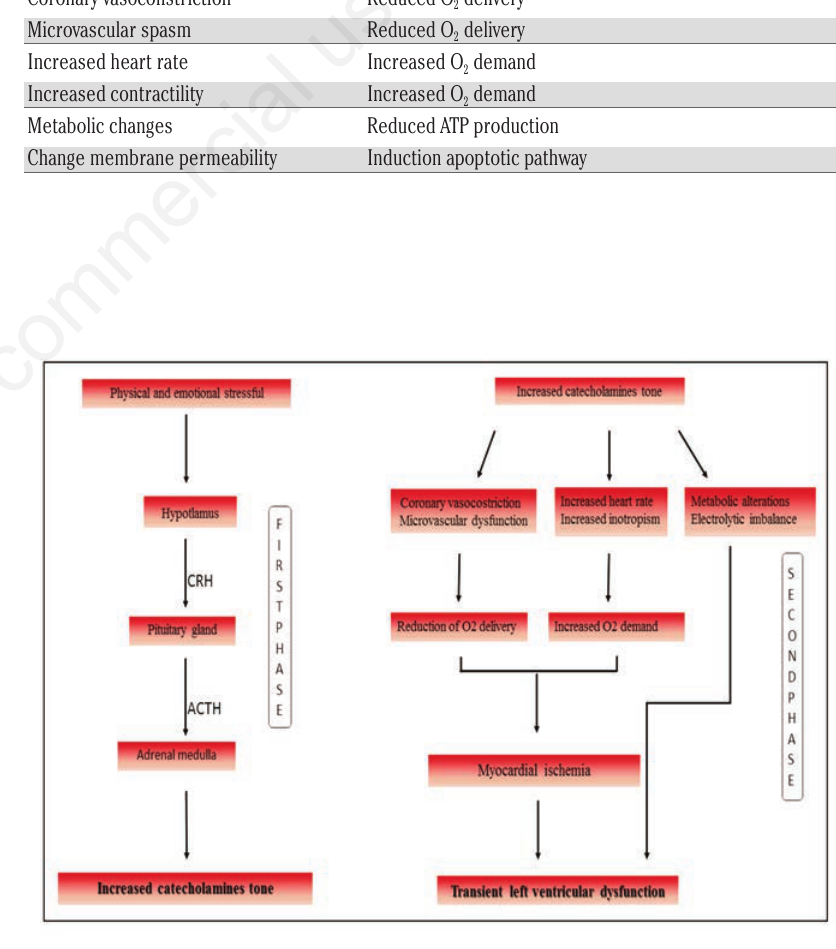
Figure 1. Pathophisiology of Takotsubo syndrome. CRH, corticotropin releasing hor- mone; ACTH, adreno corticotropic